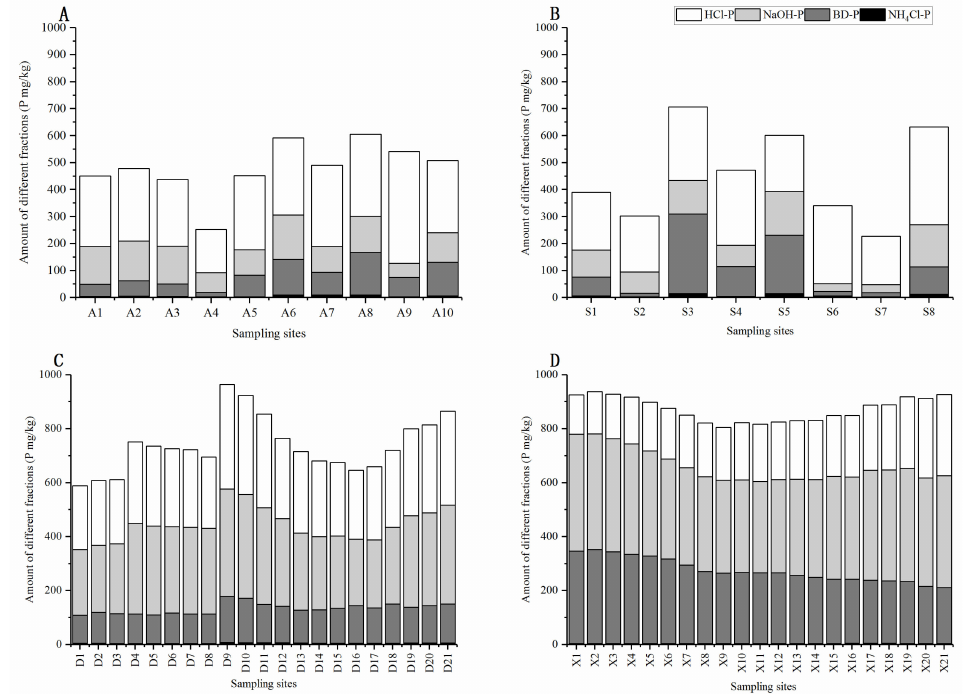
Figure 3. The concentration of di ff erent P fractions in di ff erent sediments of rivers: ( A ) Anhe, ( B ) Suihe, ( C ) Dongtiaoxi, and ( D )